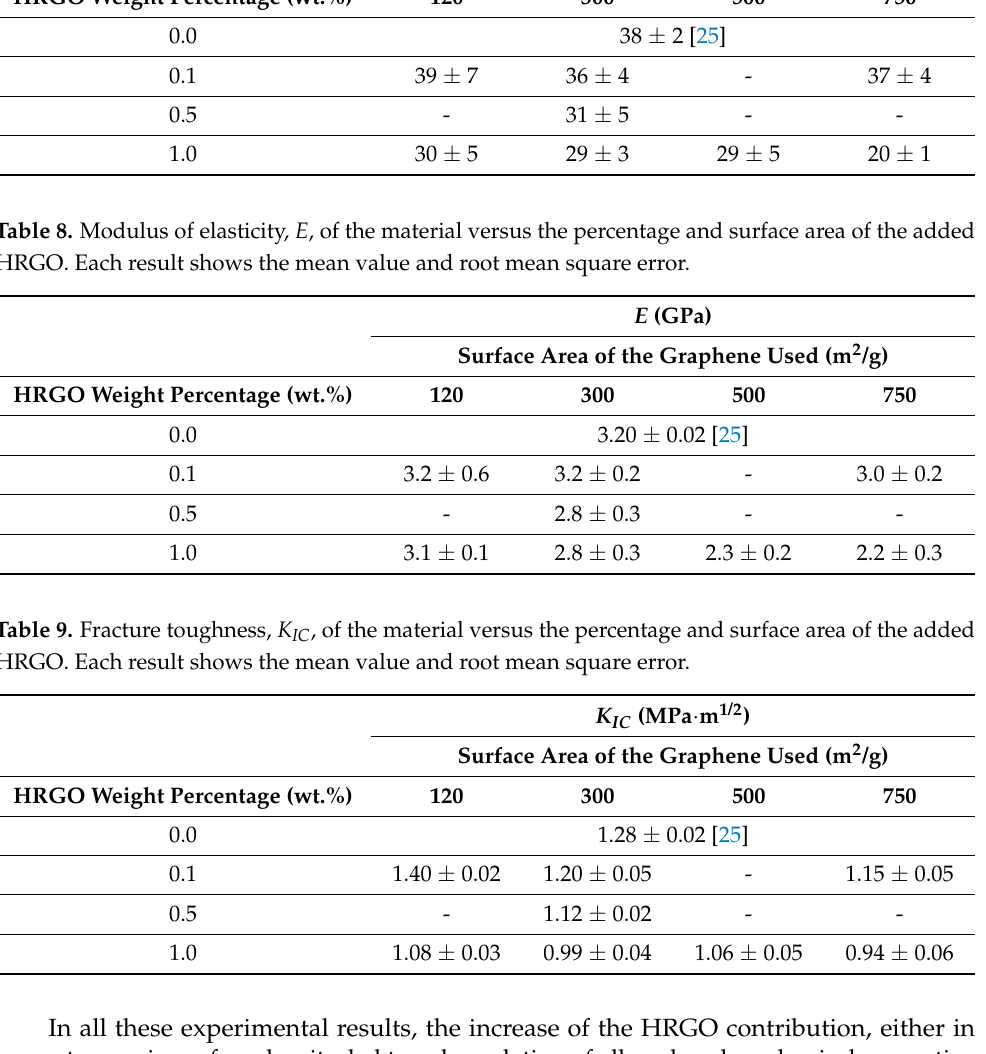
Table 7. Tensile strength, σ t , of the material versus the percentage and surface area of the added HRGO. Each result shows the mean value and root mean square error. σ t (MPa) Surface Area of the Graphene Used (m 2 /g) HRGO Weight Percentage (wt.%) 120